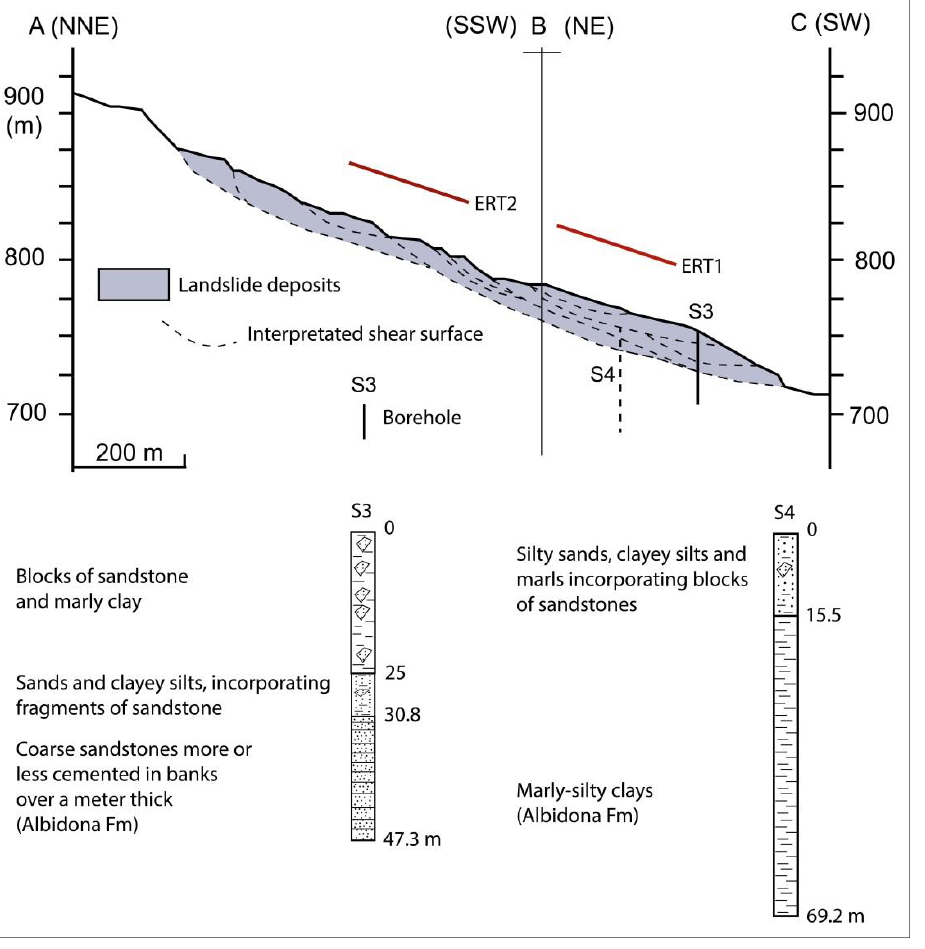
Figure 8. Geomorphological section of the Servigliano landslide of 1907 with superimposed boreholes according to Lentini & Schilirò (1982) 3 . For sections outline (A-B and B-C) see Figure 7. The Figure also shows the location of ERT (see Section 3.2.).